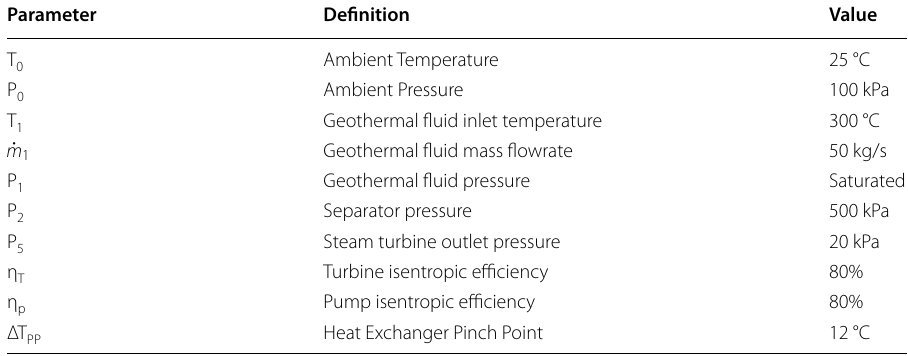
Table 2 Current study’s design parameters